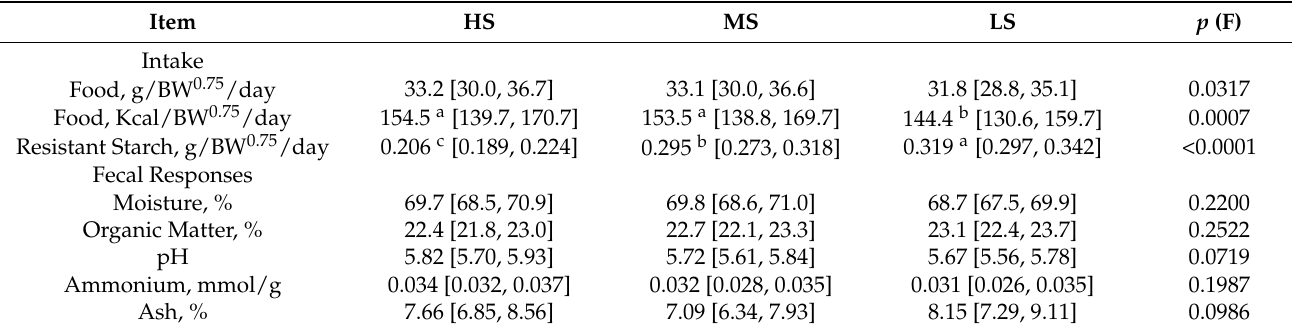
Table 2. Food intake and fecal parameters (estimated least squared means and [95% confidence interval]) of dogs fed dietary treatments produced at high, medium, and low shear (HS, MS and LS,